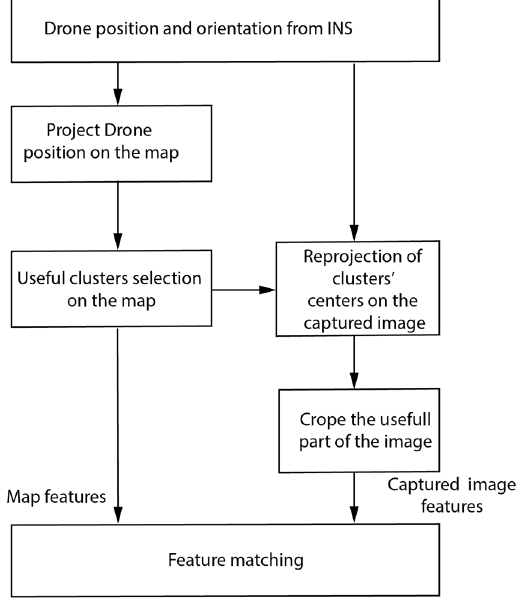
Figure 4. The diagram for features-matching enhancement using the drone INS